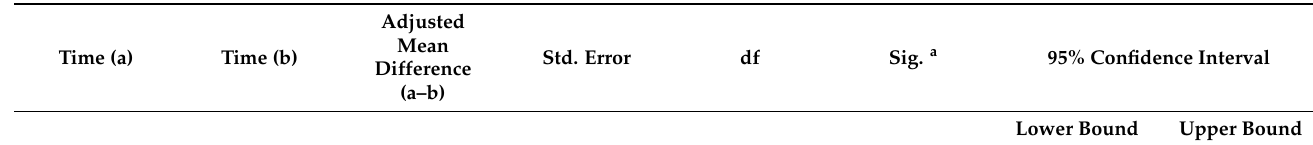
Table A7. Pairwise comparisons of the mean difference in the oPMN CD marker counts and H3Cit